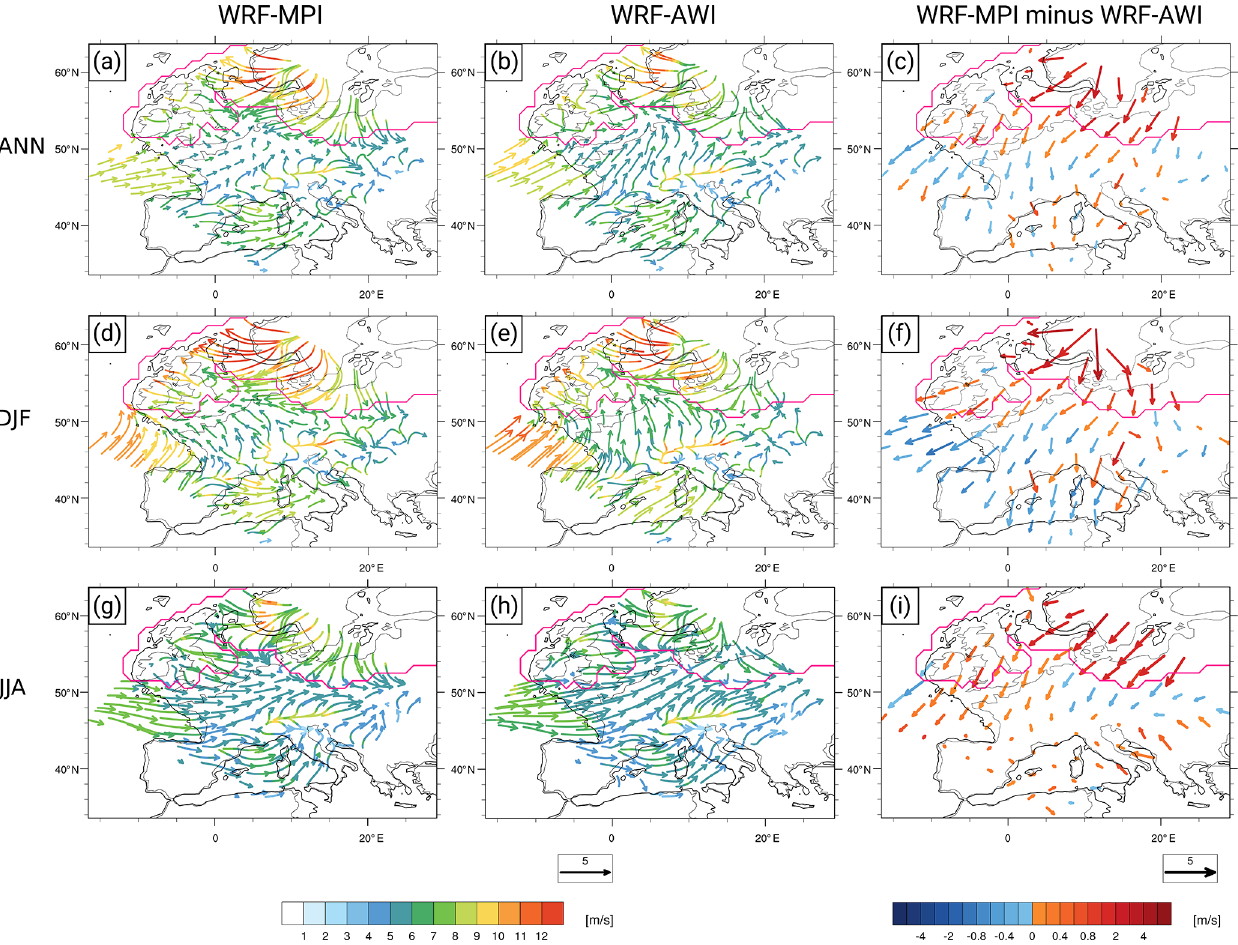
Figure 5. Distribution of 10m wind speed in annual (a–c) and seasonal winter (d–f) and summer (g–i) means as simulated with the regional WRF model with MPI forcing ( a , d , and g ) and with AWI forcing ( b , e , and h ) as well as their differences ( c , f , and i ). The black line shows the LGM coastline, and the pink line denotes the LGM ice